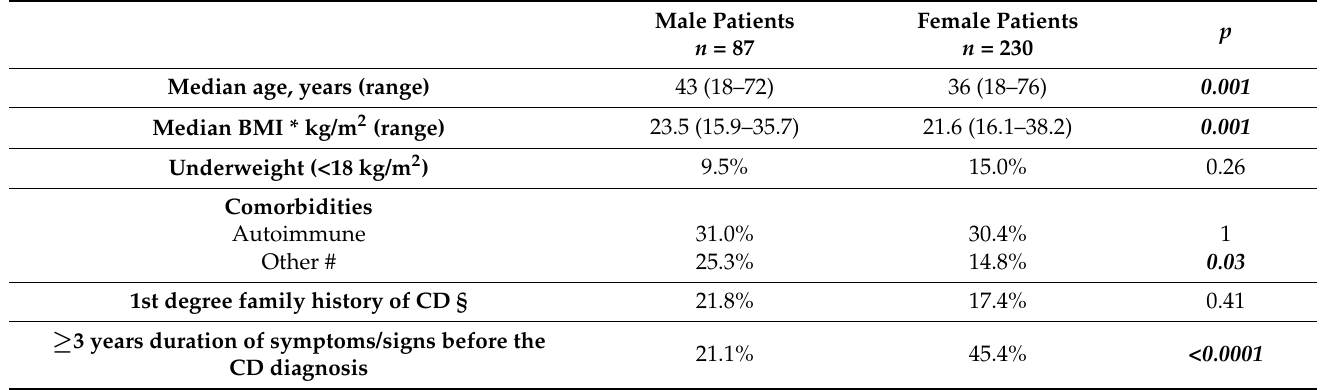
Table 1. Features and comparison between male and female patients at coeliac disease diagnosis